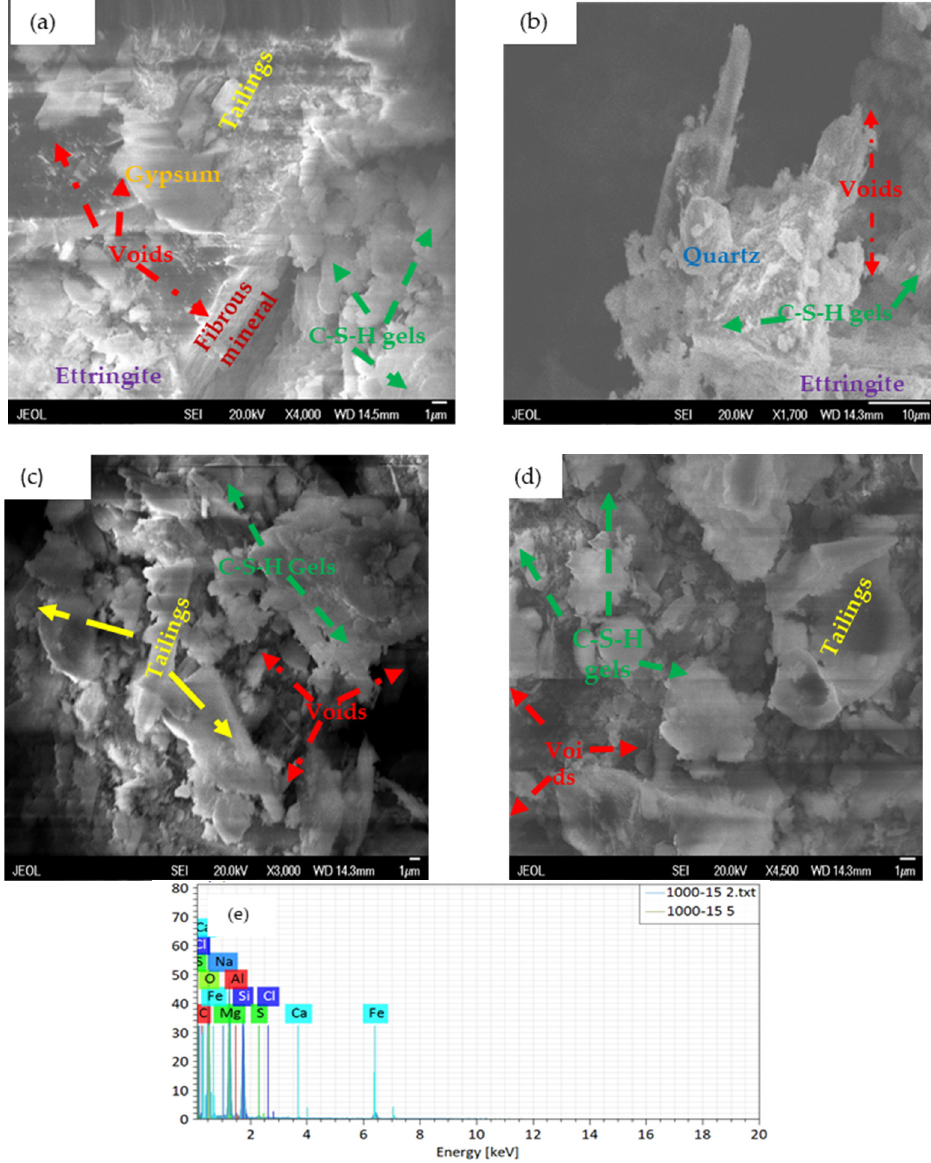
Figure 8. SEM-EDS microstructural evolution of CWTB at solids content 75 wt. % as a function of curing time ( a ) 14, ( b ) 28 and ( c , d ) 42 days at different binders’ dosage and ( e ) EDS spectrum of multi-elements.